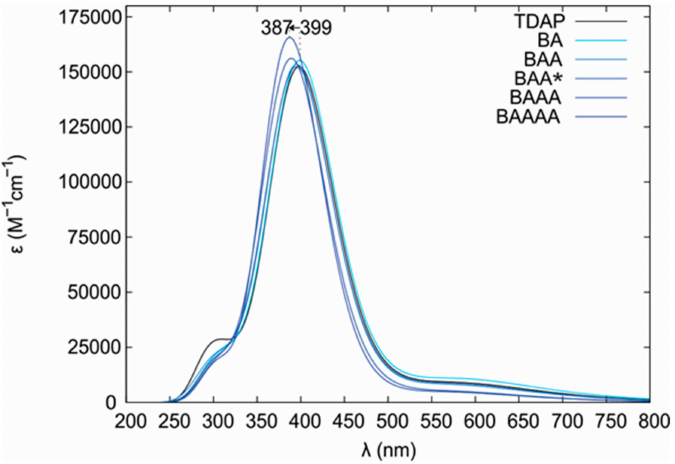
Figure A1. Theoretical spectra of TDAP titration with